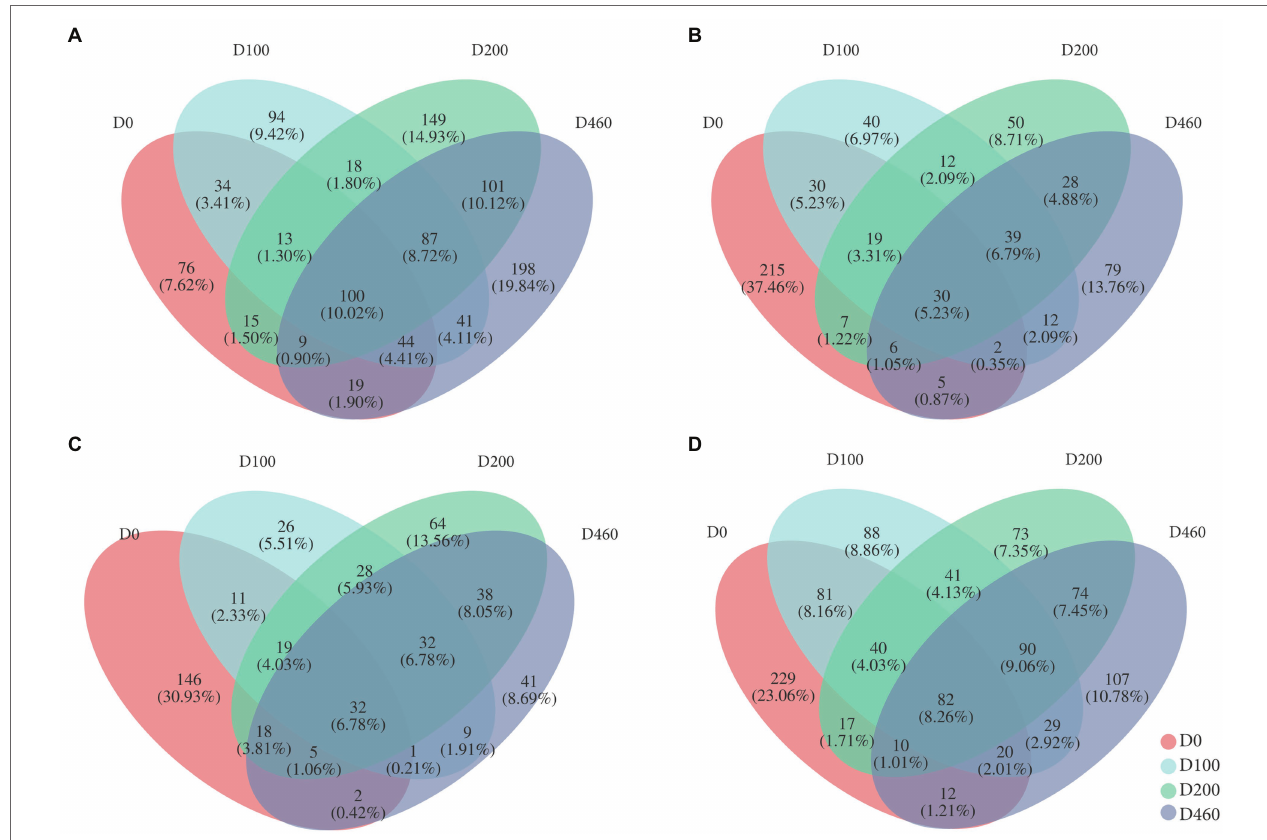
FIGURE 2 | Venn diagrams of litter fungi at OTU level in S516 (A) , S536 (B) , S560 (C) , and the whole copper mining area (D) . The percentage written in parentheses means the special species as a percentage of total